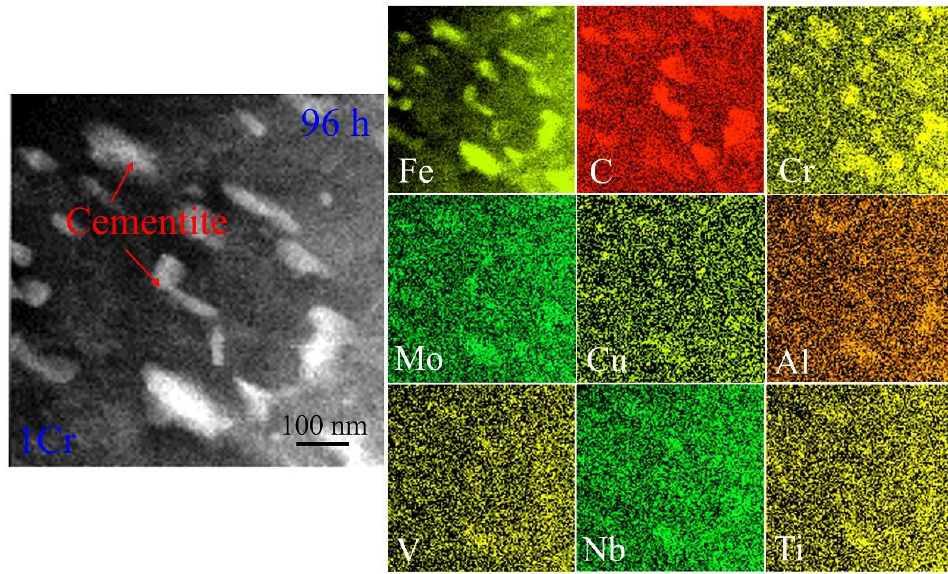
Figure 8. HAADF EDS maps of alloying elements Fe, C, Cr, Mo, Cu, Al, V, Nb and Ti in the 1Cr samples crept for 96 h. samples crept for 96